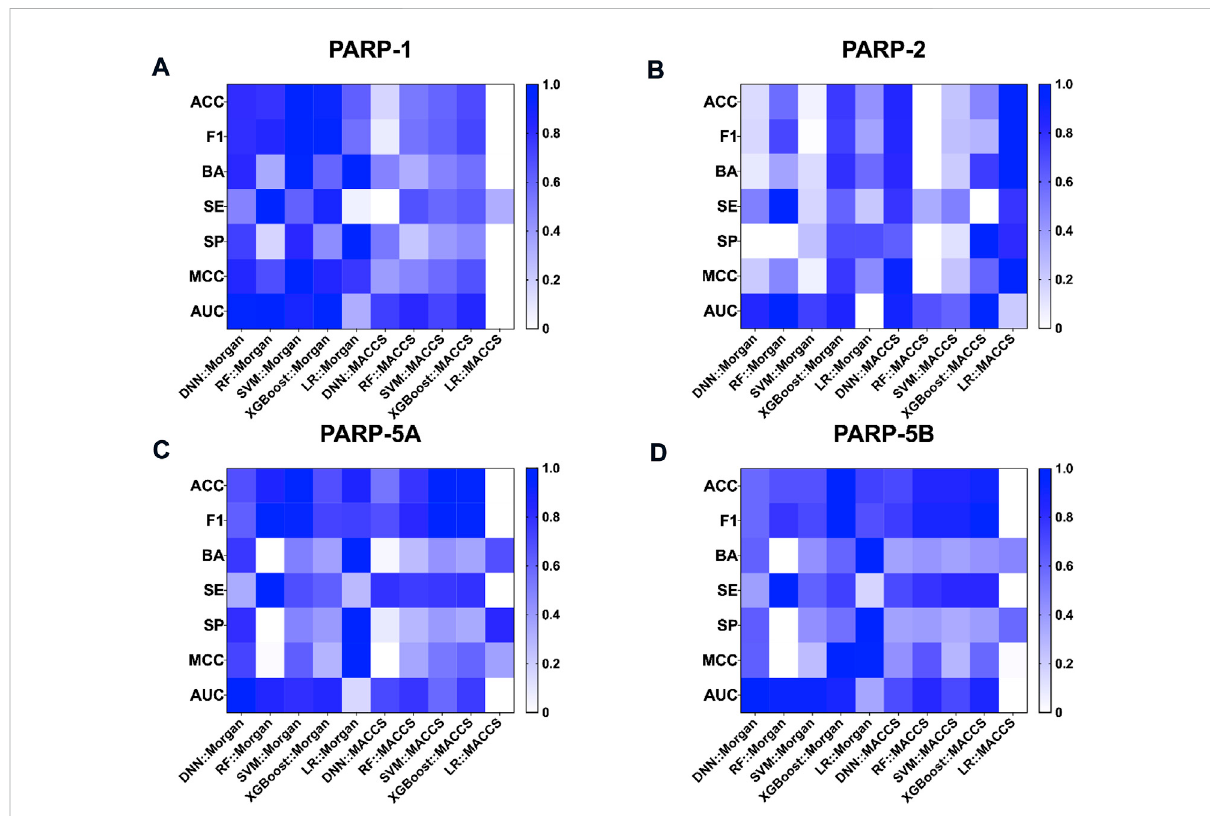
FIGURE 4 Performance of fi ngerprint-based prediction models on the test sets of PARP-1 (A) , PARP-2 (B) , PARP-5A (C) , and PARP-5B (D) .